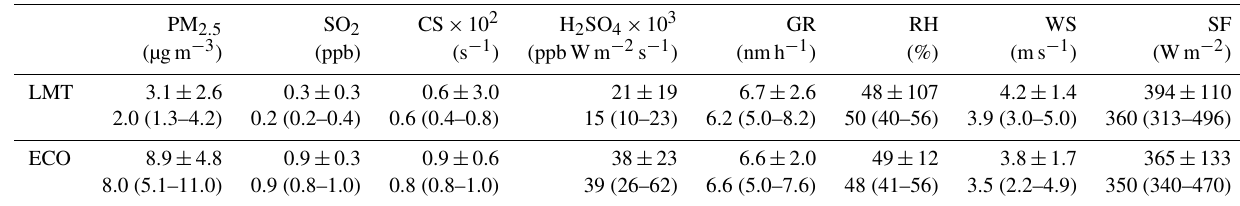
Figure 9. The 72h back trajectories arriving at LMT (up) and ECO (down) during four simultaneous new particle formation events. The maps were retrieved from NOAA HYSPLIT Model. Table 4. Arithmetic means ± 1 standard deviation and median (25th–75th) percentiles of different parameters: PM 2 . 5 , SO 2 , CS, H 2 SO 4 , GR, RH, WS, and SF for both